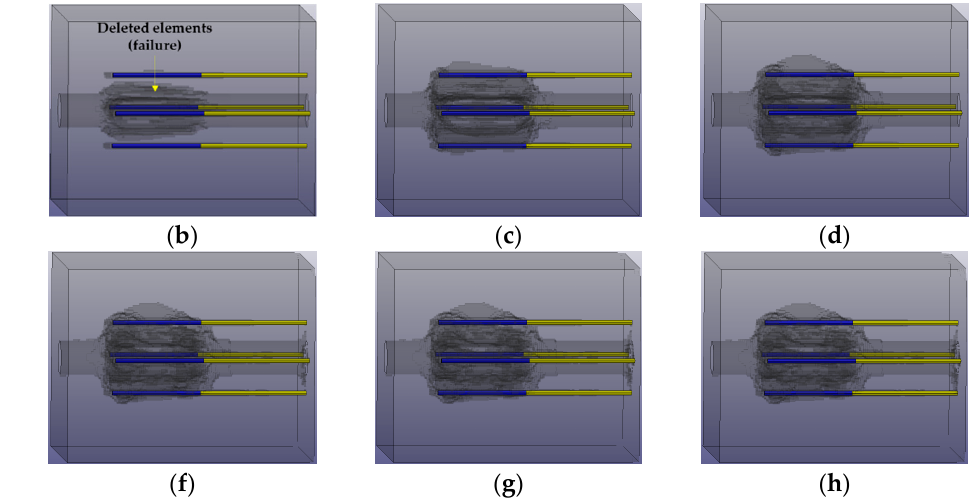
Figure 7. Results of numerical analysis of the LLB method: ( a ) 0 ms, ( b ) 0.5 ms, ( c ) 1.0 ms, ( d ) 1.5 ms, ( e ) 2.0 ms, ( f ) 2.5 ms, ( g ) 3.0 ms, ( h ) 3.5 ms.